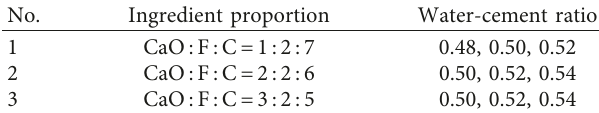
Table 1: Mixture and water-cement ratios.